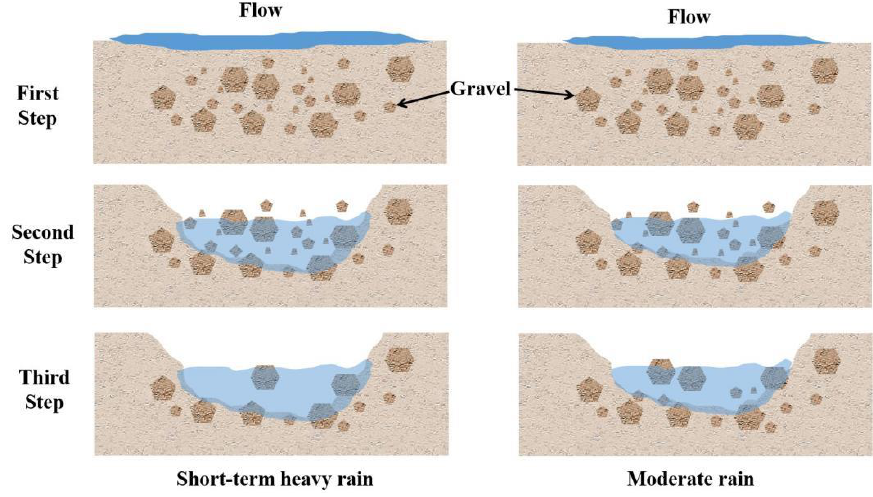
Figure 11. Schematic diagram of the washout process of short-term heavy rainfall and moderate rainfall.